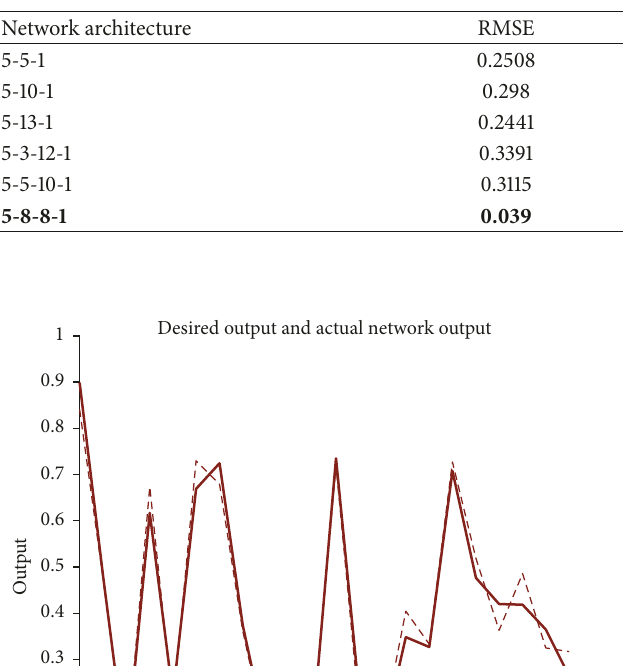
Table 4: Performance of neural networks in the coupled static-dynamic loading case.